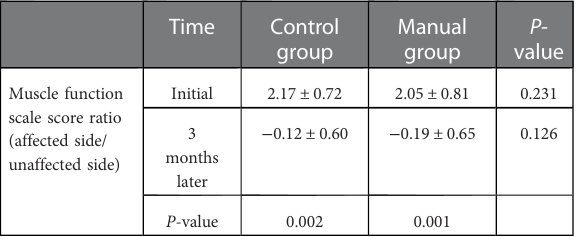
TABLE 3 Changes in the ratio of muscle function scale